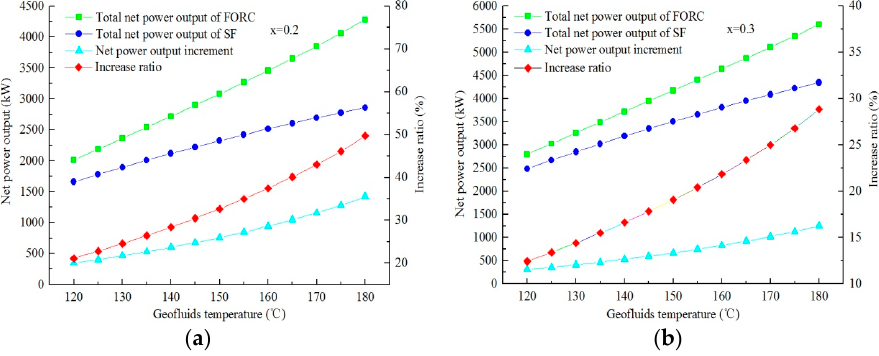
Figure 9. Variations of net power output of FORC with geofluid temperature: ( a ) x = 0.2; ( b ) x = 0.3.